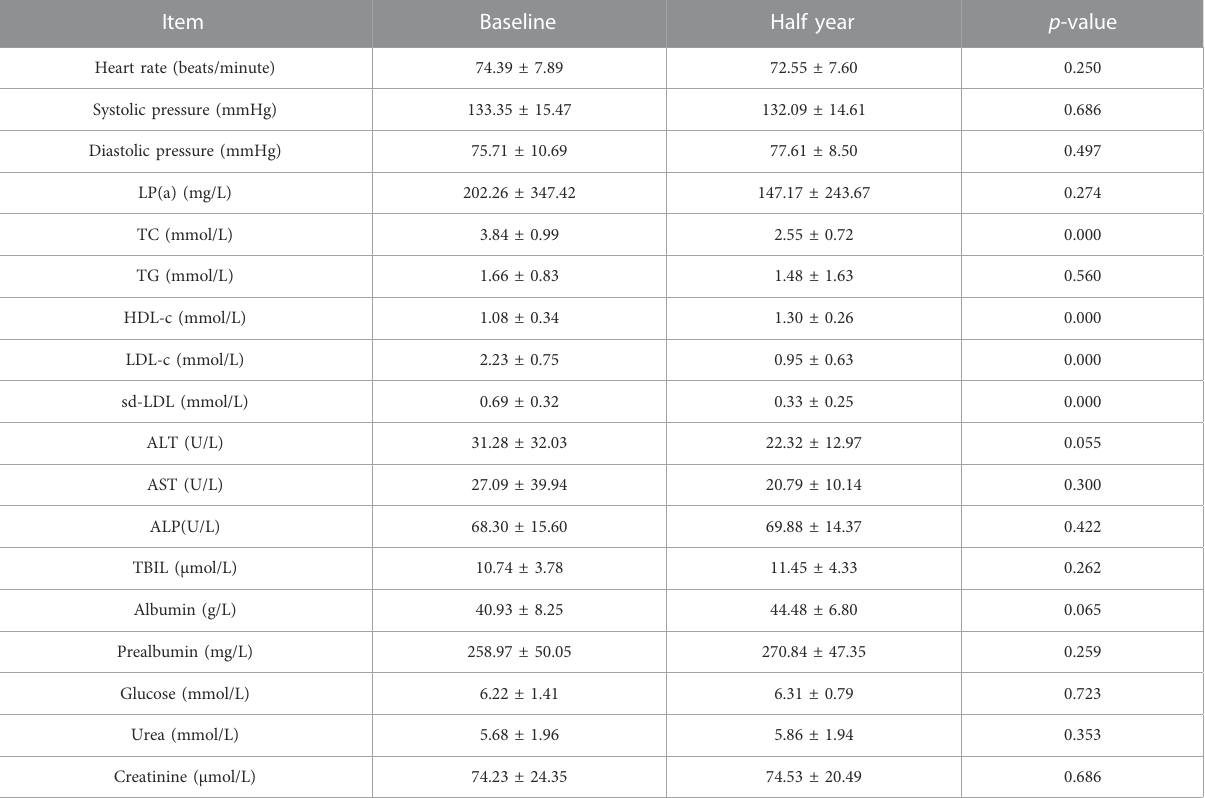
TABLE 2 Comparison of heart rate, blood pressure, blood lipid and biochemical